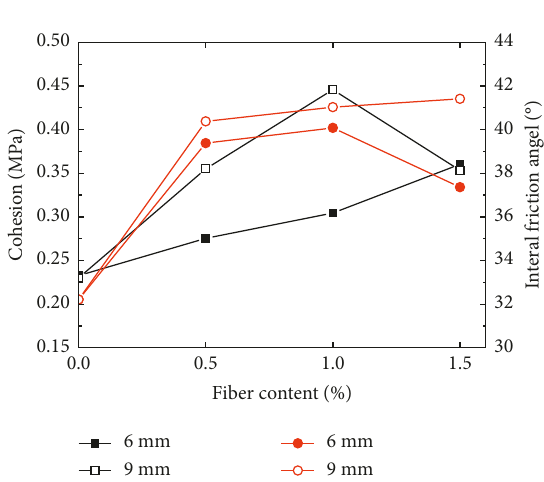
Figure 10: Relationship between (c) and φ